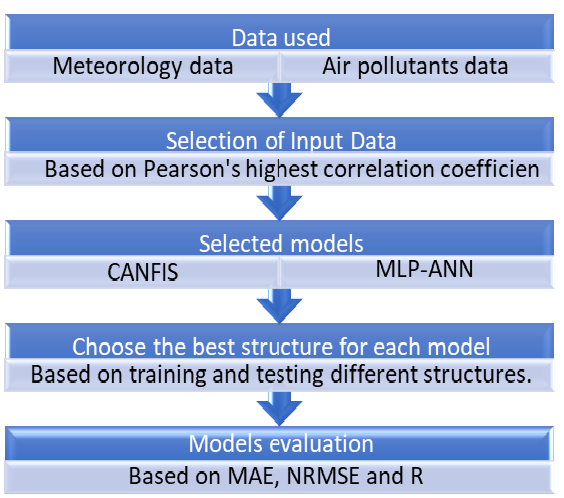
Fig. 1. A schematic view of the research